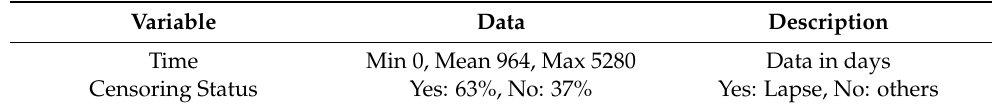
Table 5. Description of the Response Variable.